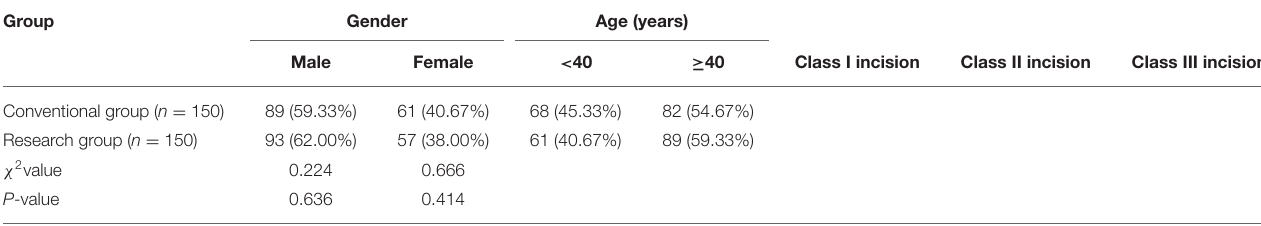
TABLE 1 | Comparison of general data between the two groups ( n , %). Group Gender Age (years)